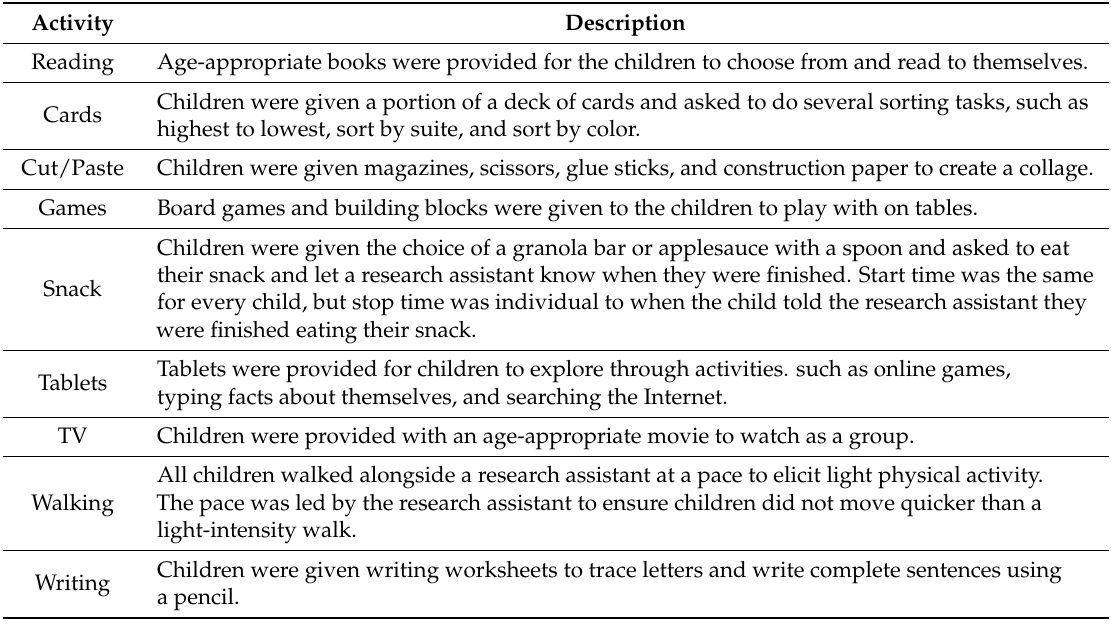
Table 1. Description of performed